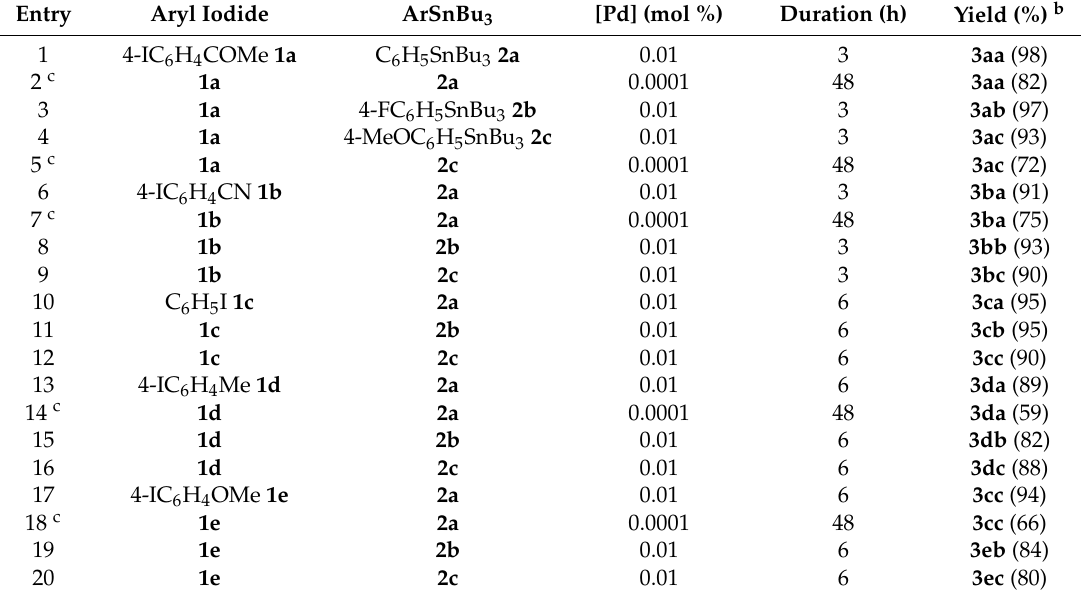
Table 2. Pd-catalyzed Stille coupling of aryl iodides ( 1 ) and aryltributylstannane ( 2 ) in water a .